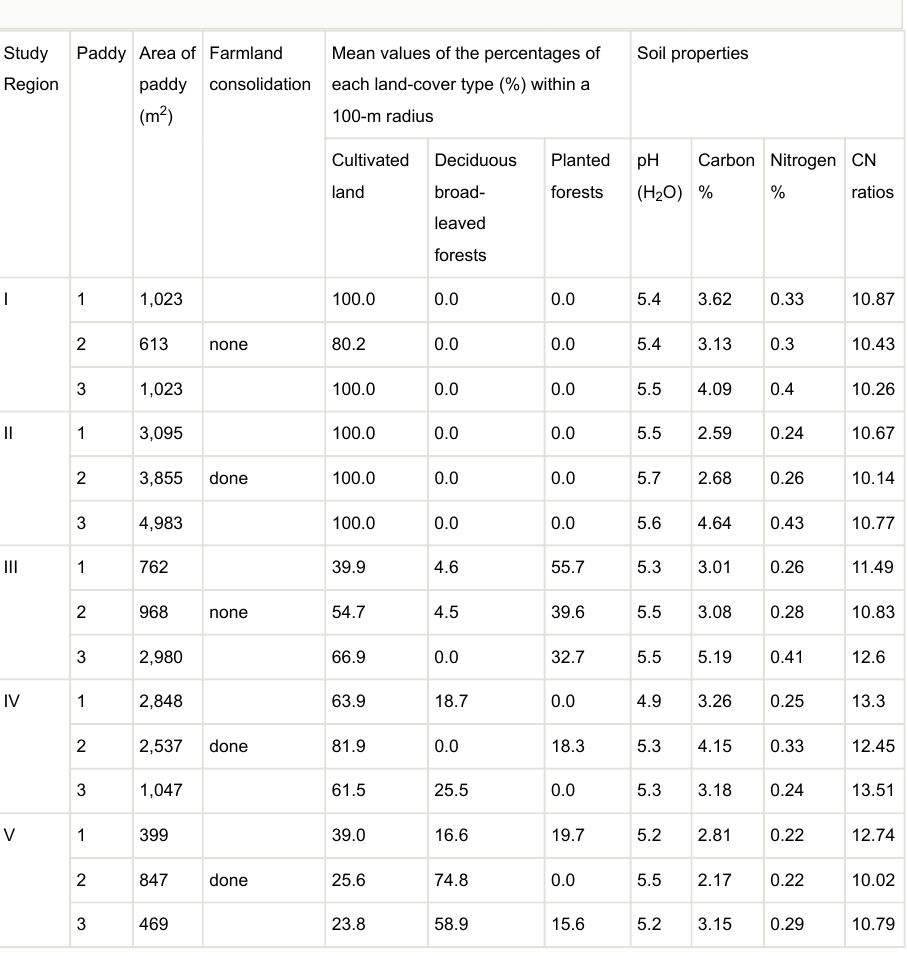
Detailed characterisations for each study paddy and region. See Suppl. material 1 for the methods for the measurements of landscape conditions and soil